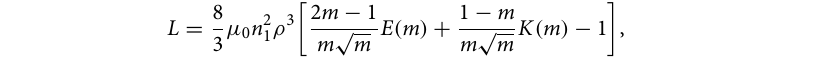
Figure 4. Inductance L of a constant-radius single-layer coil as a function of ξ the maximum on the curve. The filled dot shows the true optimum. L is in units of µ 0 W ρ and l definitions of ¯